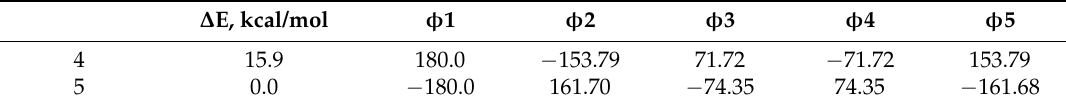
Table 2. Calculated relative energies ( ∆ E, kcal/mol) and torsion angles (degrees, torsional angles: